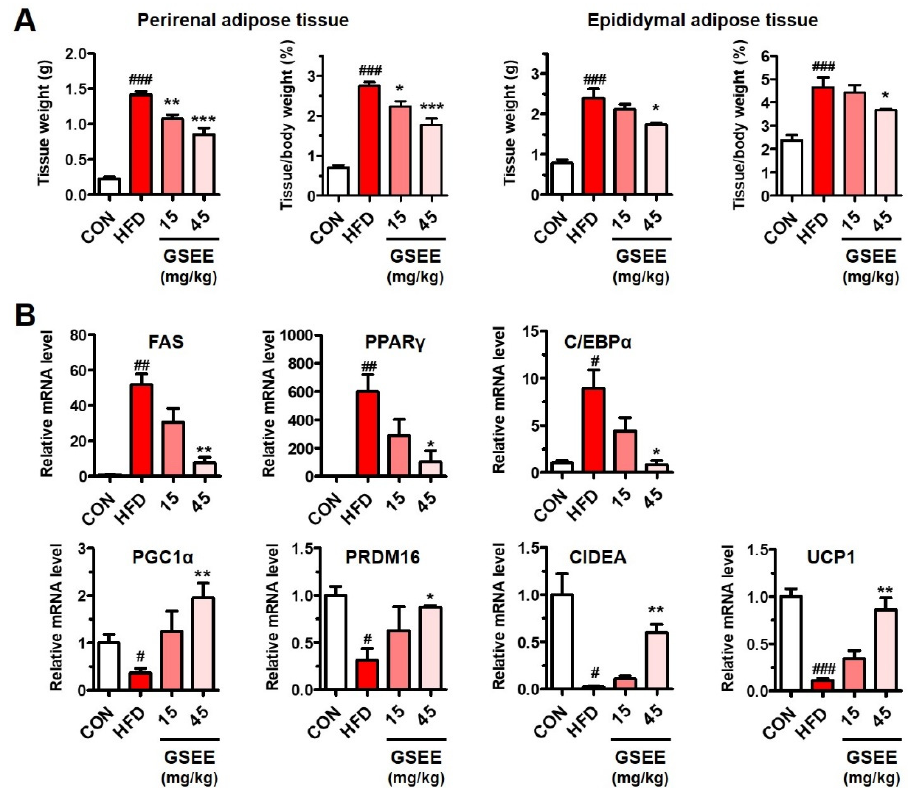
Figure 9. E ff ects of the GSEE on the adipose tissue weights, and the gene expressions involved in lipid metabolism and adipocyte di ff erentiation in HFD-fed obese mice: ( A ) perirenal and epididymal adipose tissue weights and the ratios to body weight (%); ( B ) relative mRNA expressions. Mice ( n = 8 in each group) were fed with HFD for 10 weeks with or without daily oral administration of GSEE (15 or 45 mg / kg of body weight). Adipose tissues from randomly selected 3 mice in each group were used for qRT-PCR. Values are represented as mean ± SE. Student’s t -test, #, ##, ### p < 0.05, 0.01, and 0.001, respectively vs. control. *, **, *** p < 0.05, 0.01, and 0.001, respectively, vs.